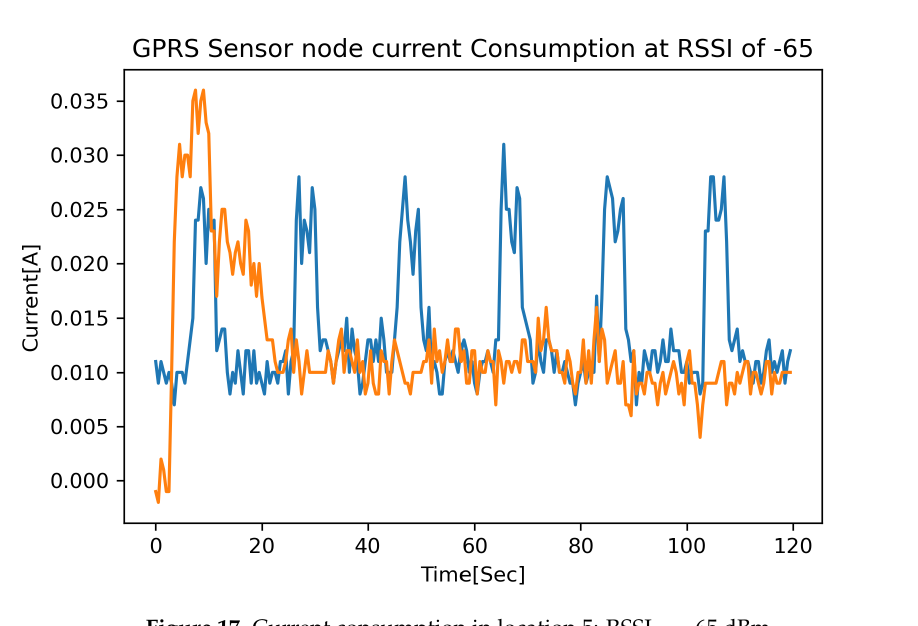
Figure 17. Current consumption in location 5: RSSI = − 65 dBm.